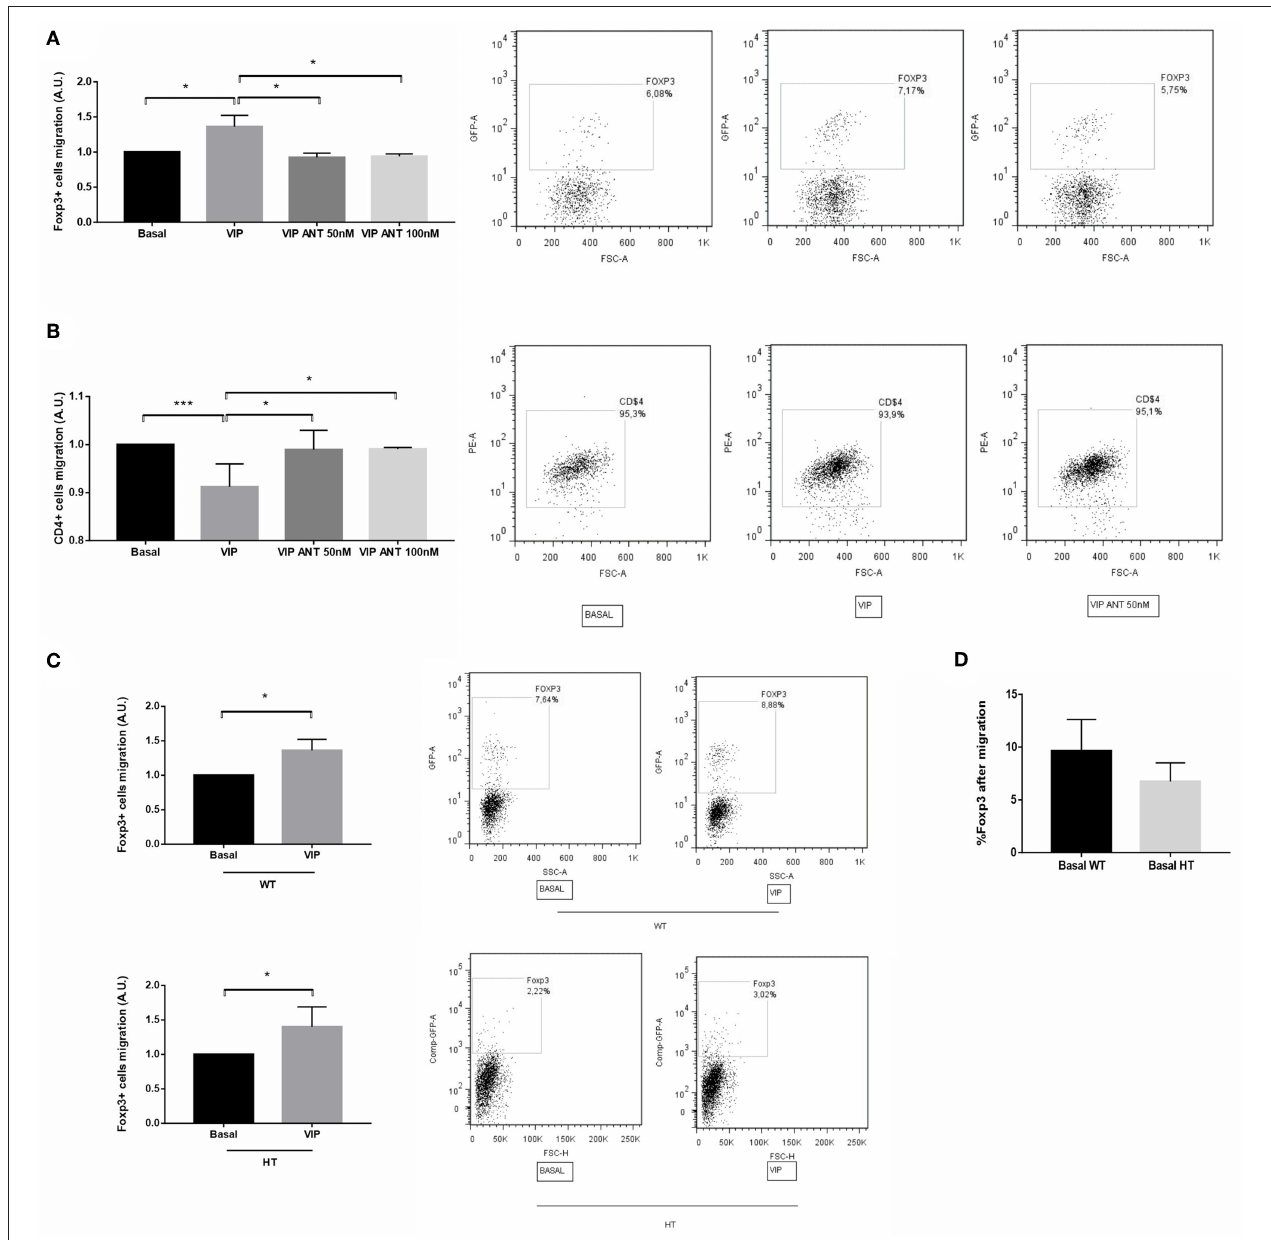
FIGURE 5 | Vasoactive intestinal peptide (VIP) antagonist treatment in vitro prevents Treg recruitment toward early implantation site. Early implantation sites were recovered from WT × WT mating at d5.5 and treated ex vivo with VIP (50nM) or VIP antagonist (50 and 100nM) during 24h, then the conditioned media (CM) were recovered and used for migration assays. CD4 + cells were sorted from draining lymph nodes from FOXP3-GFP-knock-in females. CD4 + cells were seeded in transwell system and set in a 24-well plate containing the CM. After 24h, the cells were recovered from the lower compartment and the frequency of (A) CD4 + FOXP3 + and (B) CD4 + cells were quantified by flow cytometry analysis. The right panel shows representative dot plots with the % of FOXP3 + cells (inside the electronically gated CD4 + cells). Negative control samples were incubated in parallel with an irrelevant, isotype-matched Ab and used for cut-off setting. (C) The same experiments were performed in the presence of CM from heterozygous (HT) implantation sites in the absence/presence of VIP. Comparison was performed relative to each basal migration without VIP treatment. (D) % of FOXP3 + cells recovered from the lower compartment after migration toward CM from WT or HT implantation site under basal conditions (without VIP treatment). Results are representative of four assays run similarly (* p < 0.05 and *** p < 0.001, Mann-Whitney Test).